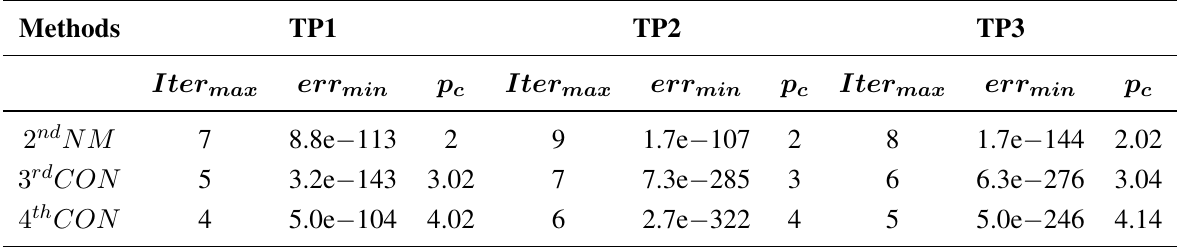
Table 1. Comparison of different methods for systems of nonlinear equations.